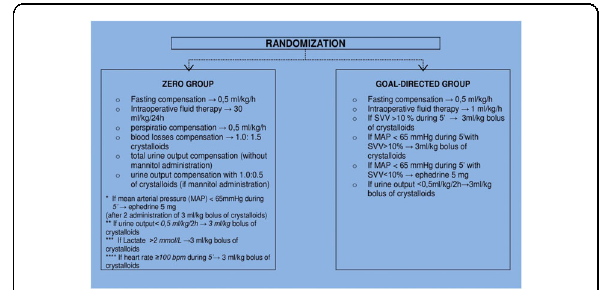
Table 1 (abstract 001615). Univariable analysis of BIB associated with mortality. +Mean±SDE BIB